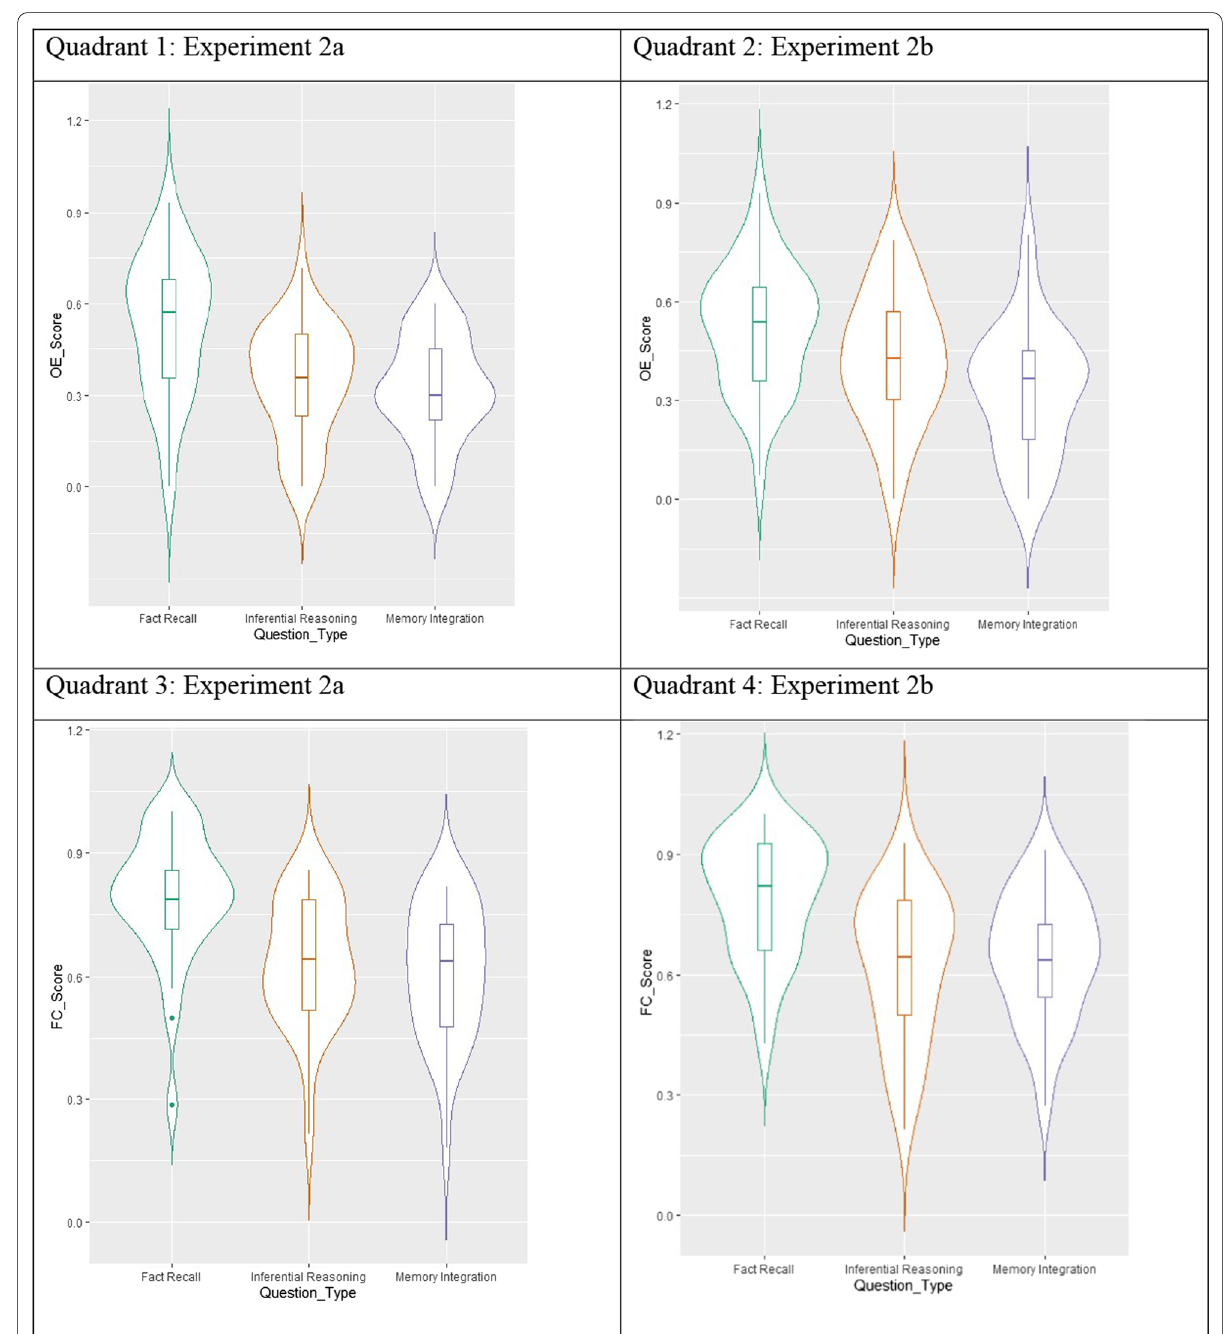
Fig. 4 Open‑ended and forced‑choice learning outcomes across question types in Experiments 2a (Retrieval Practice) and 2b (Restudy). Note Violin plots depict variability and proportion correct for open‑ended (OE) and forced‑choice (FC) performance within three question types (Fact Recall, Inferential Reasoning, and Memory Integration) in Experiment 2a (Quadrants 1 and 3) and 2b (Quadrants 2 and